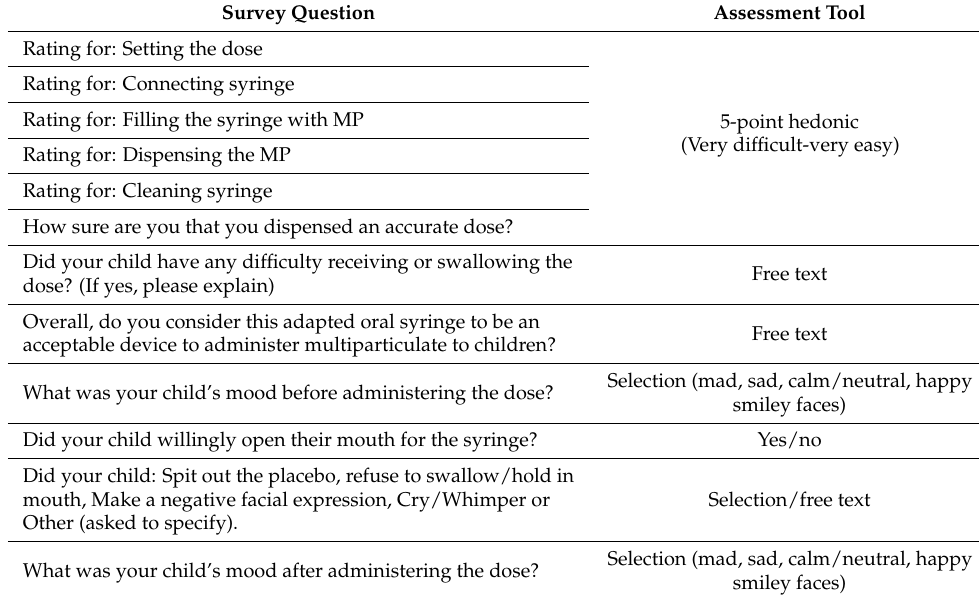
Table A1. Survey questions for parent and child participants ages